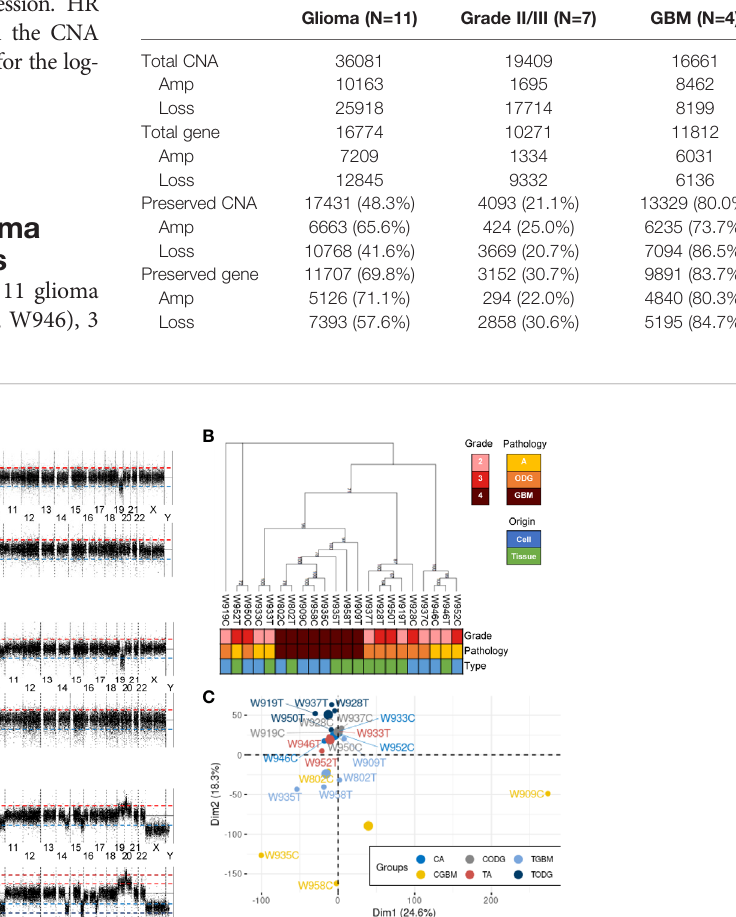
TABLE 2 | Summary of the CNA presence in patient specimens and the CNA preservation in patient-derived primary cells.